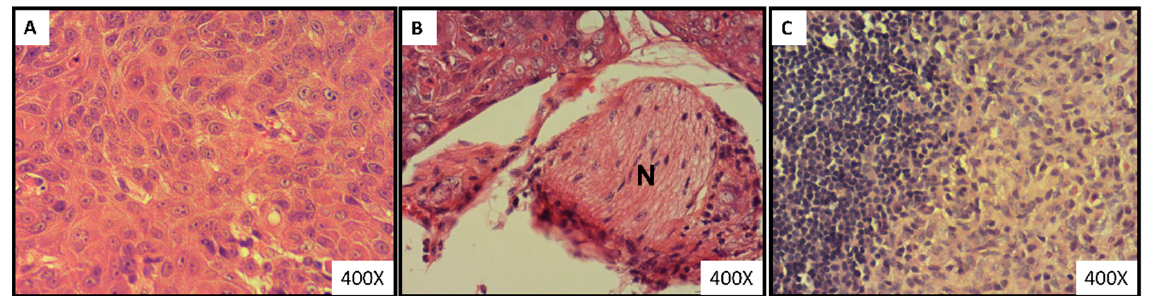
Figure 2. Tongue section of CAL-27 xenograft-bearing mice stained with H&E at 400 × magnification. ( A ) Well-differentiated squamous cell carcinomas. ( B ) Perineural invasion surrounding the nerve fiber (N). ( C ) Histiocytosis in the lymph